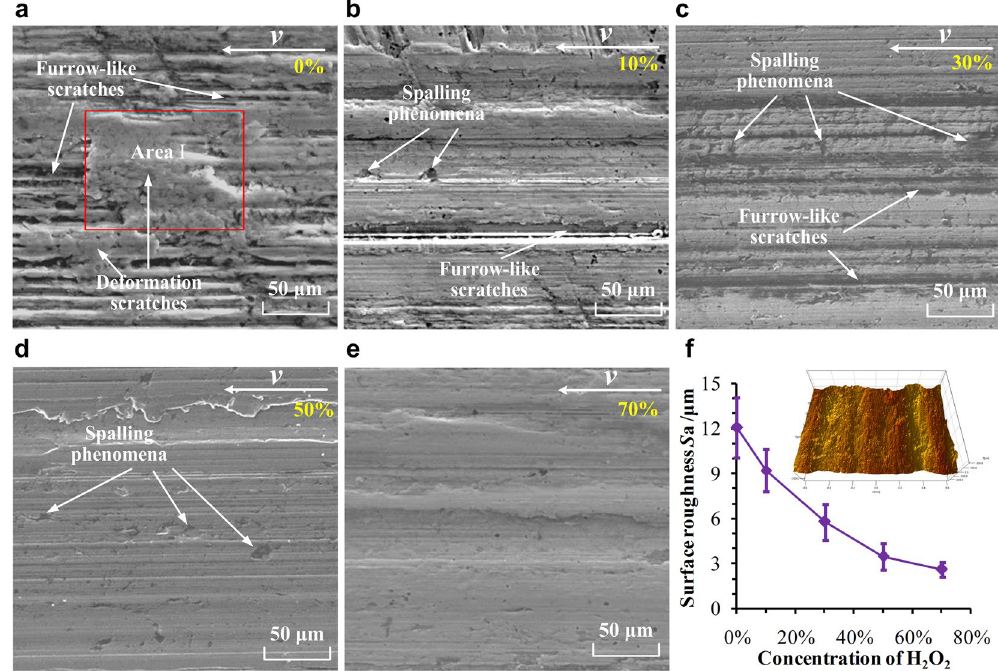
Figure 3. SEM images of wear surfaces of the 304 ring-discs tested in ( a ) 0%, ( b ) 10%, ( c ) 30%, ( d ) 50%, and ( e ) 70% H 2 O 2 solutions and ( f ) surface roughness of the wear